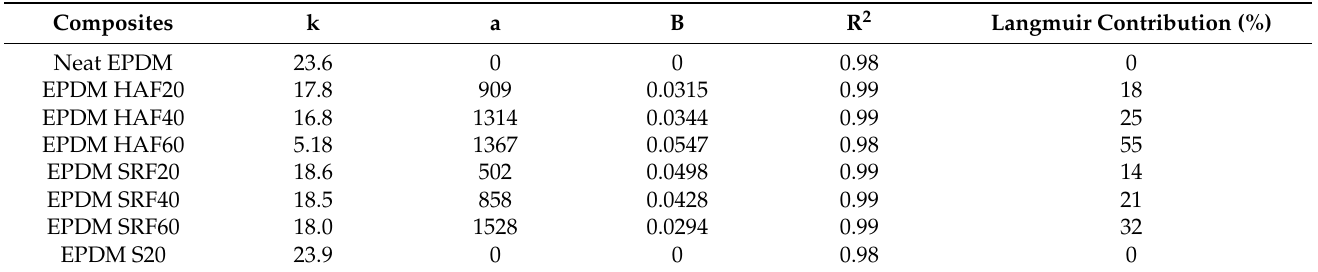
Figure 5. Relationship between H 2 uptake ( C ∞ ) and exposure pressure for ( a ) neat EPDM, ( b ) EPDM S series, ( c ) EPDM HAF40, and ( d ) EPDM SRF40. The blue and black lines represent the Henry fit and the dual mode (Henry–Langmuir) fit, respectively. The legends show the linear least-squares fitting plots and their squared correlation coefficients (R 2 ). Table 2. Fitting results of the sorption model for neat EPDM and EPDM rubber composites filled with HAF CB, SRF CB, and S fillers according to Equation